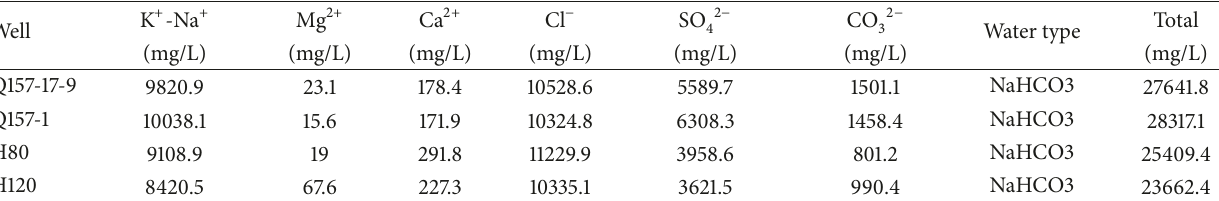
Table 3: Salinity statistics of Daqingzijing